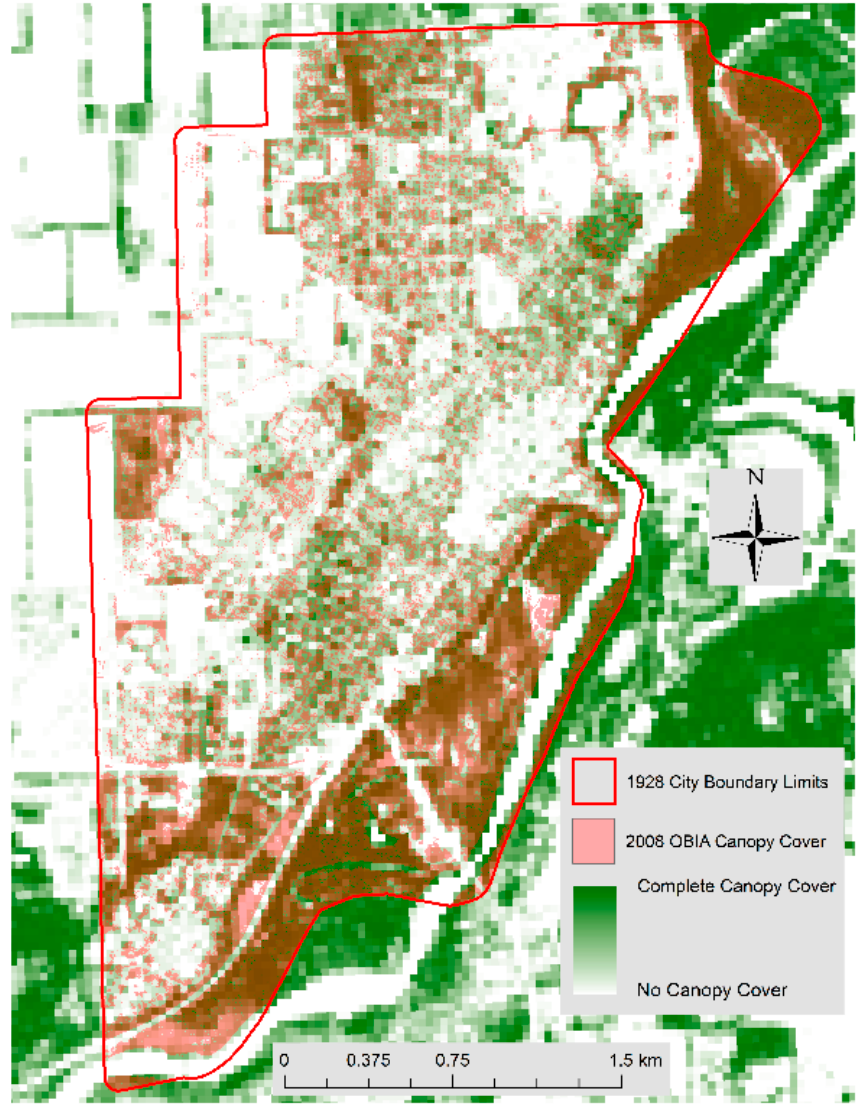
Figure 6. LiDAR canopy density.